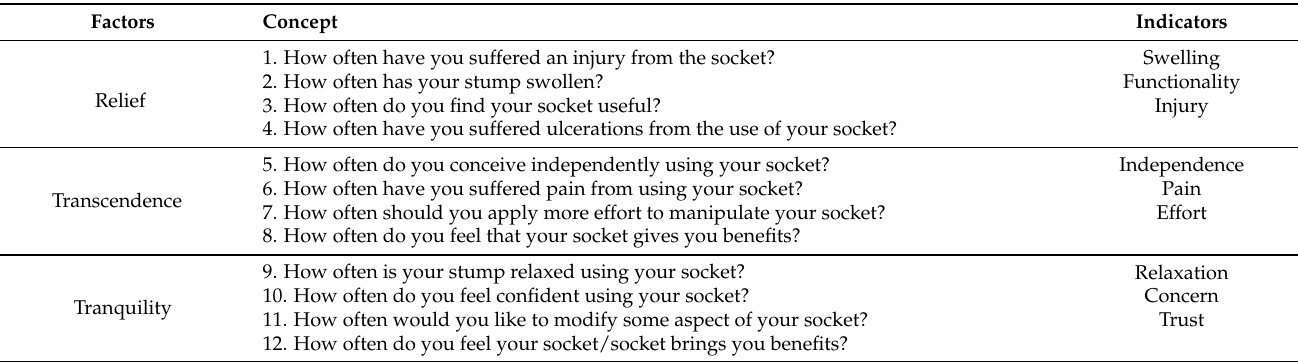
Table A5. Comfort perception